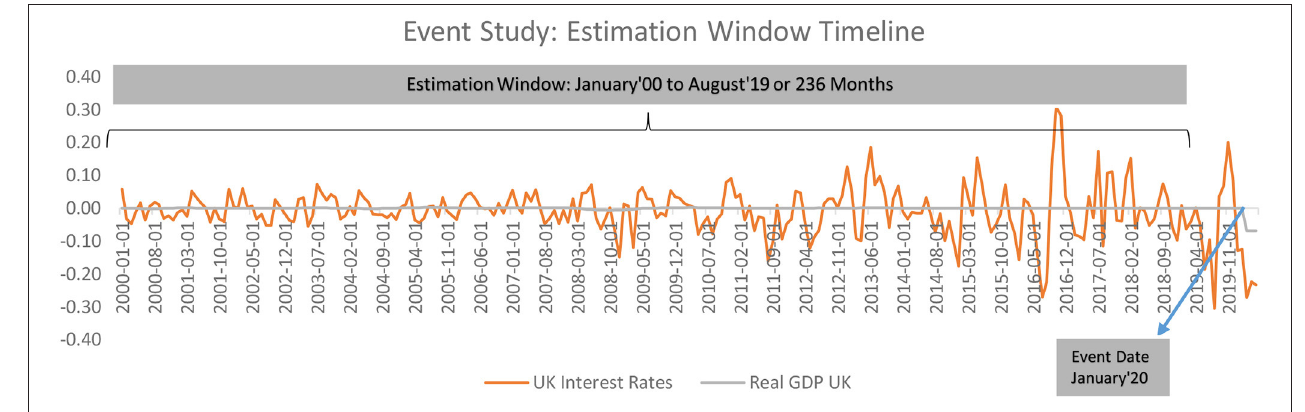
FIGURE 1 | Event timeline: Covid-19